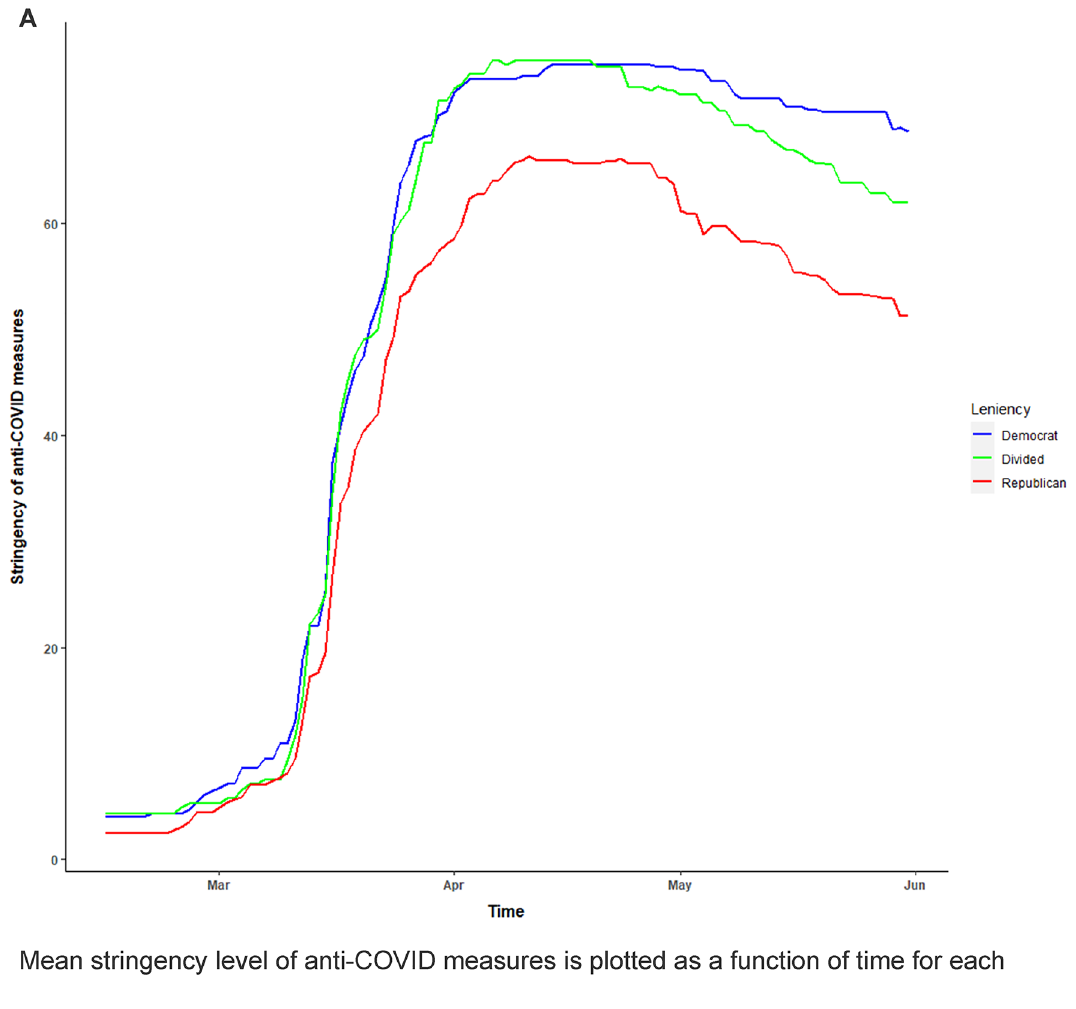
Figure 2. Stringency of anti-COVID measures ( A ) and Number of COVID-related deaths ( B ) for each political group during the first period of the pandemic (Feb 15 to May 31